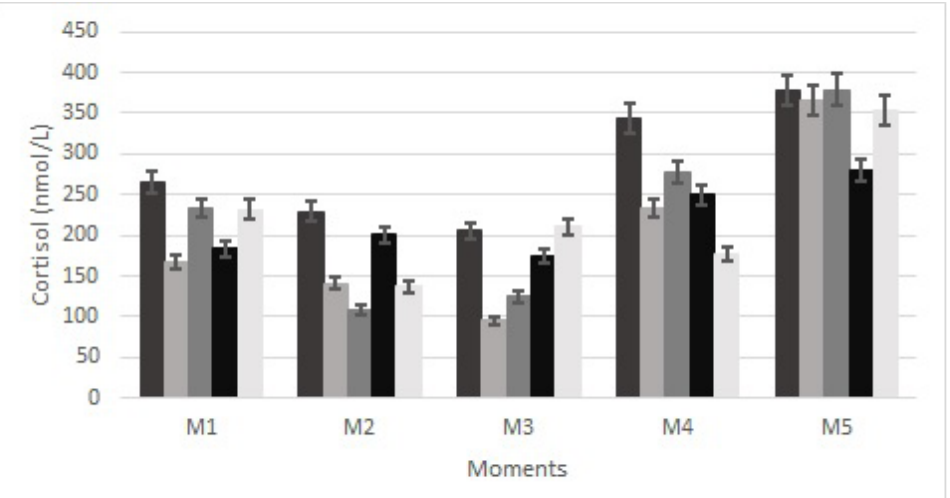
Figure 6. Graphical representation of the cortisol variation between moments (before PAM, after PAM, after anesthetic induction (GCO) or drug administration to reach the serum level (GFLK, GCE, GDEX, GDEXCE), during clamping and ligation of the ovarian pedicle, and immediately after